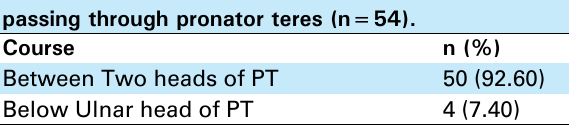
Table 1. Showing the course of median nerve while passing through pronator teres (n=54).